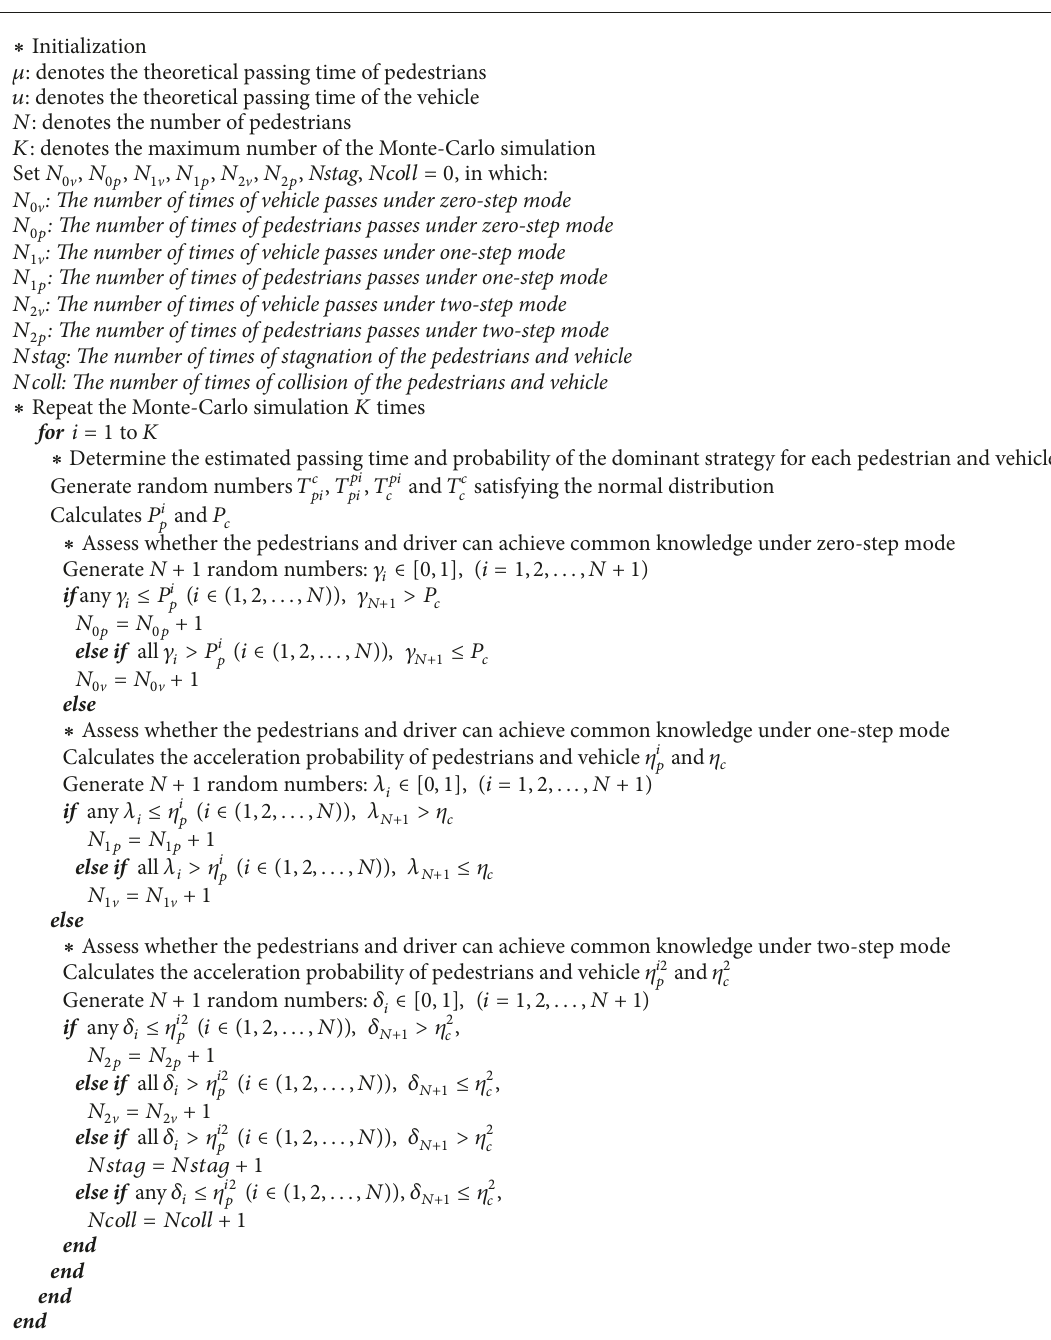
Pseudocode 1: Pseudocode implementation of the Monte-Carlo